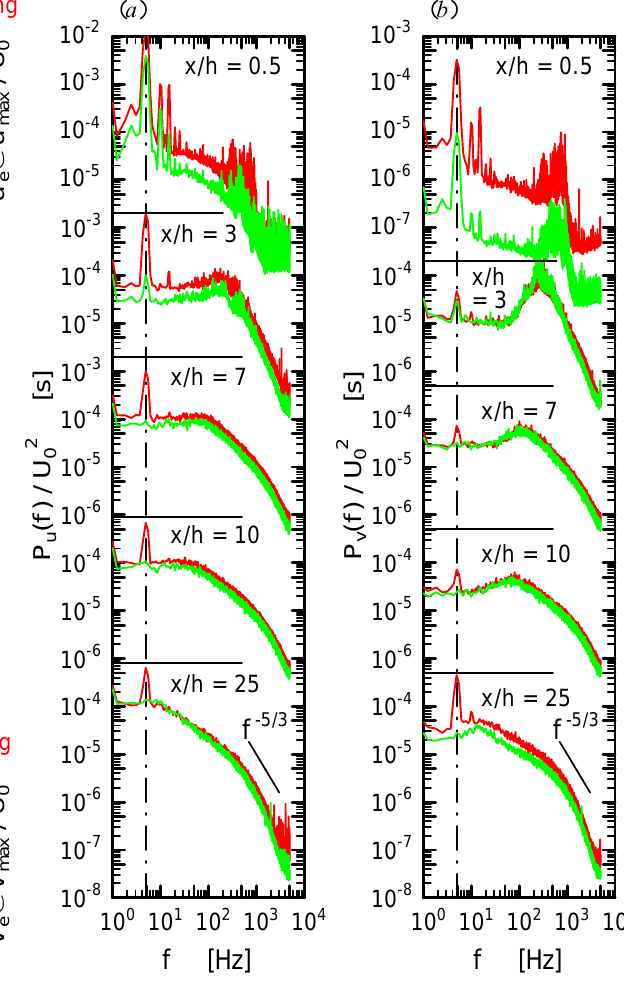
Fig. 8 Power spectrum density function of temporal fluctuating velocity in ( a ) streamwise and ( b ) normal components. green line, symmetrical oscillating state; red line, anti-symmetrical oscillating